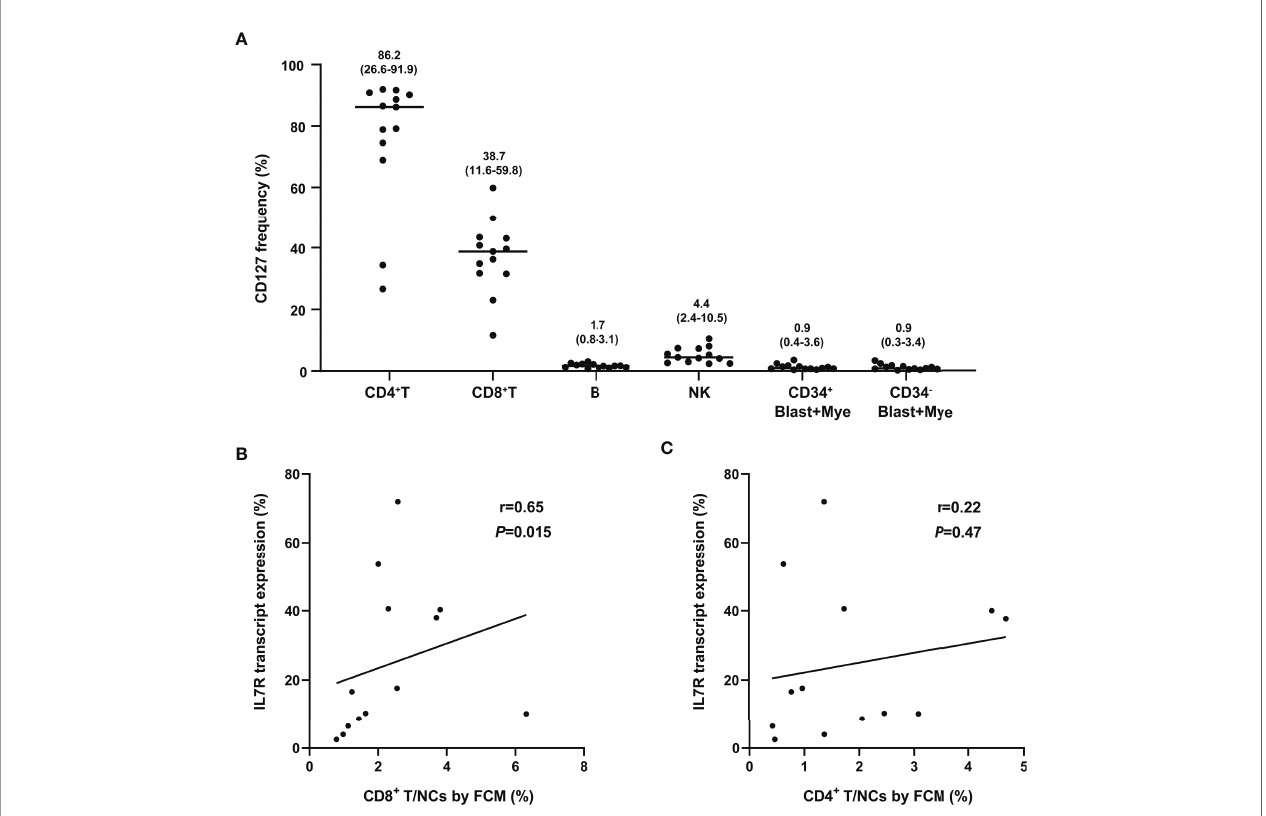
FIGURE 5 | Comparison of IL7R tested by RQ-PCR and FCM. (A) The frequency of CD127 in different cell subsets, numbers on the fi gure represent median (range); (B) Correlation of IL7R transcript expression and percentage of CD8 + T in NCs (FCM) (bivariate Spearman correlation test); (C) Correlation of IL7R transcript expression and percentage of CD4 + T in NCs (FCM) (bivariate Spearman correlation